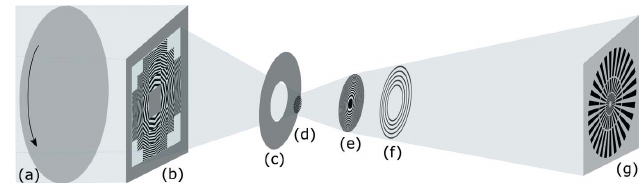
Figure 4 Sketch of the optical layout: ( a ) a rotating diffusor to reduce the coherence (optional); ( b ) a guard slit, central stop and beamshaping condenser: this ensemble provides the illumination. Note that the guard slits are only necessary because the beam size is larger than size of the order-sorting aperture. ( c ) The order-sorting aperture allows only the first diffraction order of the BSC to pass; ( d ) the sample is mounted in the working position of the optics; ( e ) the FZP focuses the magnified image of the sample on the detector system ( g ). Zernike phase rings ( f ) can be installed in the back-focal plane to change the contrast mechanism from absorption to phase